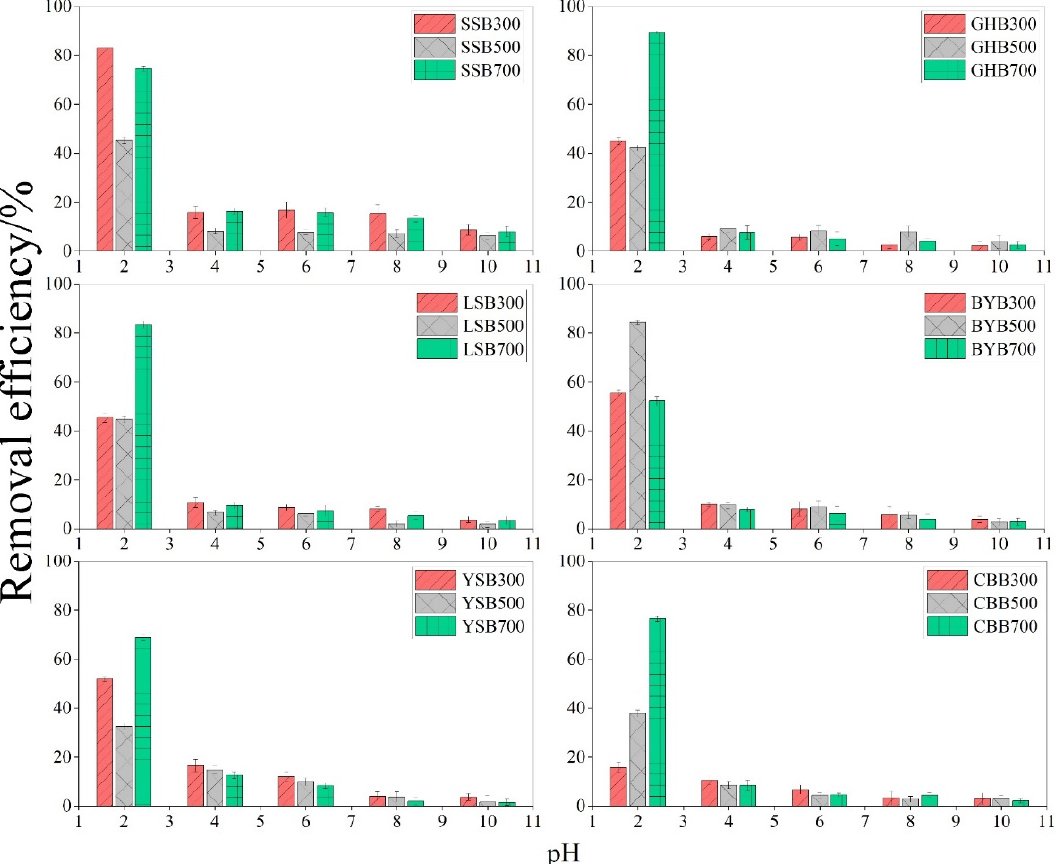
Figure 1. Relationship between pH value and Cr (VI) removal efficiency (initial Cr (VI) concentration: 50 mg · L − 1 ; dosage of biochar: 1.2 g · L − 1 ), different letters show significant differences at α = 0.05.